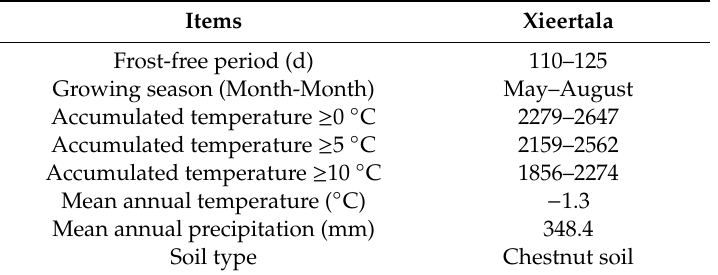
Table 1. The basic conditions of the experiment station in Xieertala Farm.